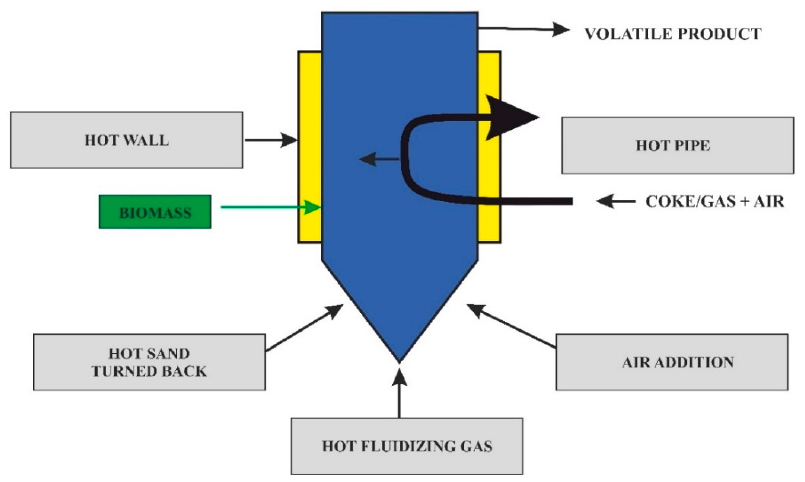
Figure 7. Diagram of the microwave-assisted biomass pyrolysis process .